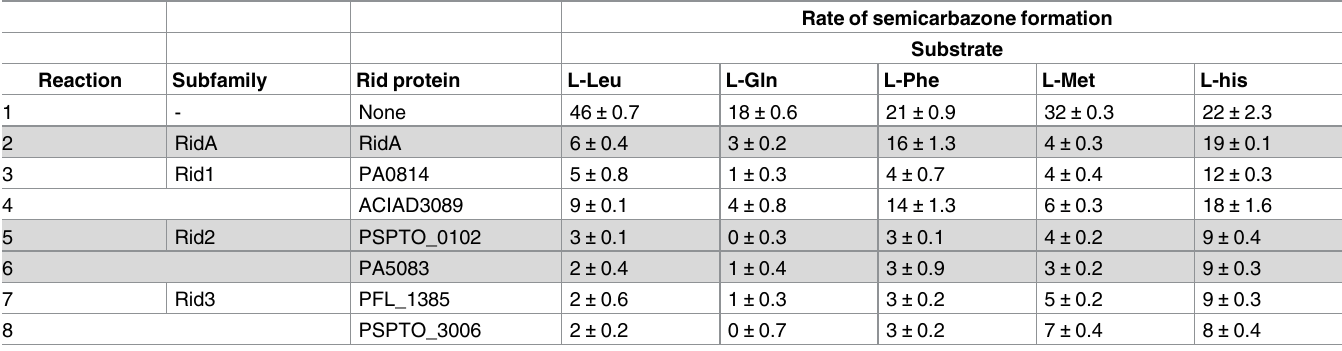
Table 4. Rid proteins deaminate a range of imine substrates a